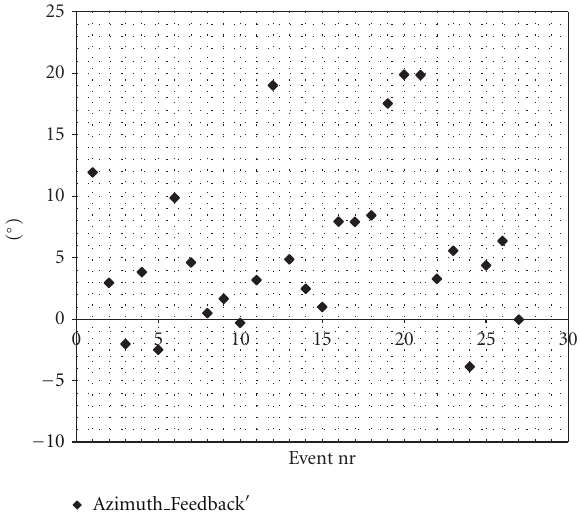
Figure 25: Unit azimuth angle during the events—starboard unit.